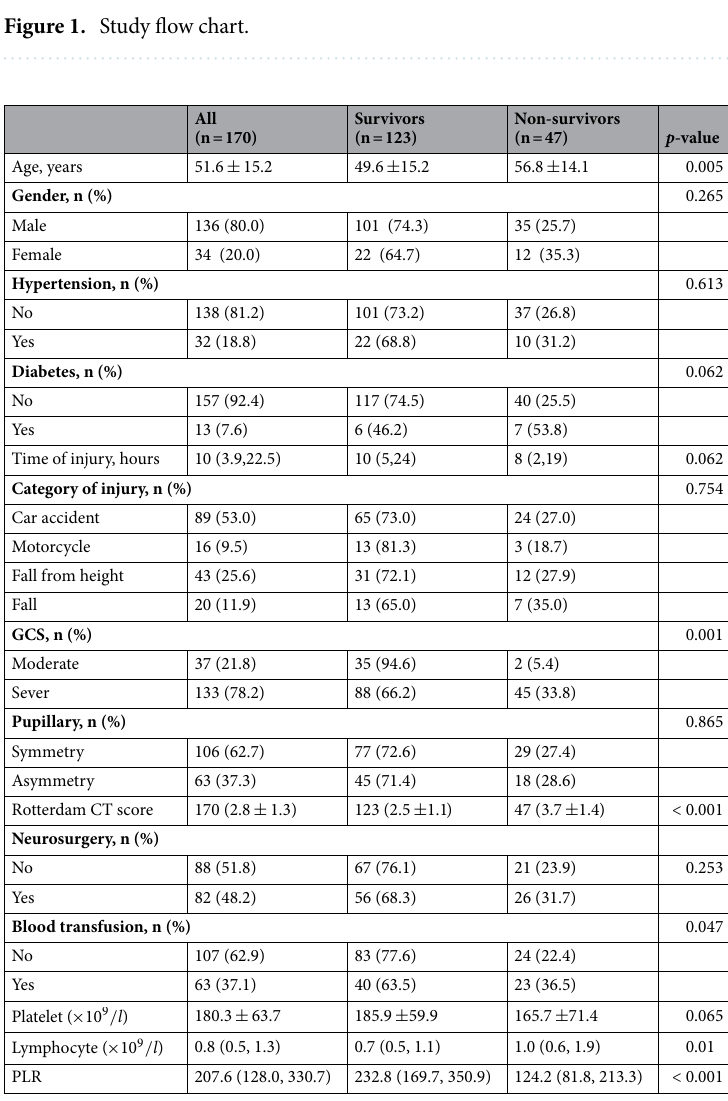
Table 1. The baseline clinical characteristics of the study